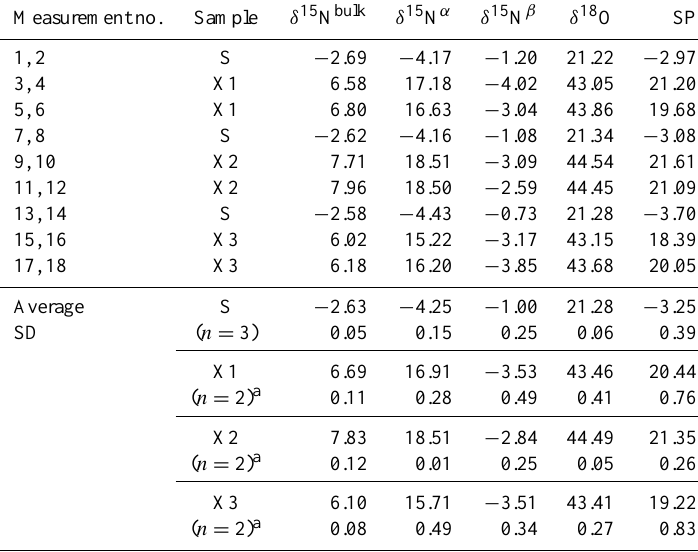
Table 2. Example of measurement results conducted on a single day. Measurement no.